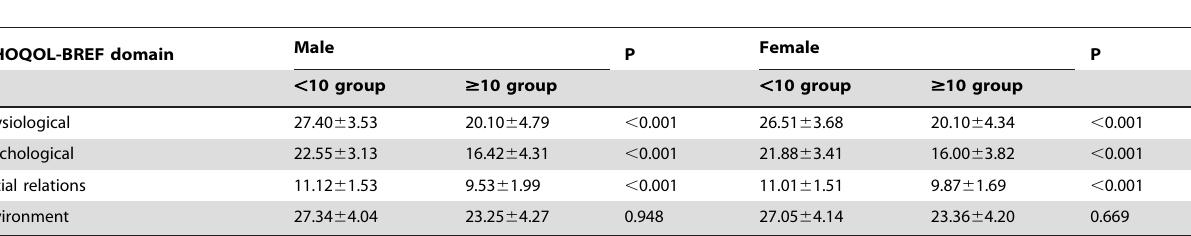
Table 4. Comparison between the PHQ-9 score $ 10 group and , 10 group in each domain score.